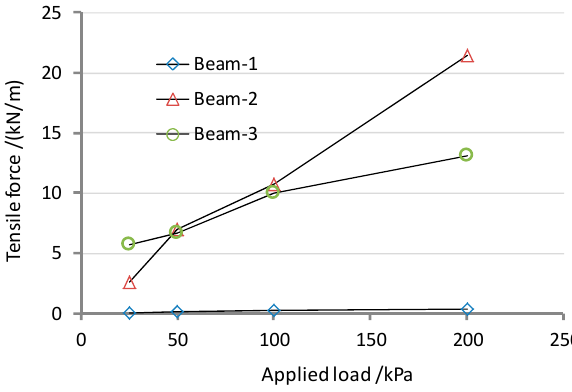
Figure 10. Tension in the geosynthetic, at anchorage from FLAC models.